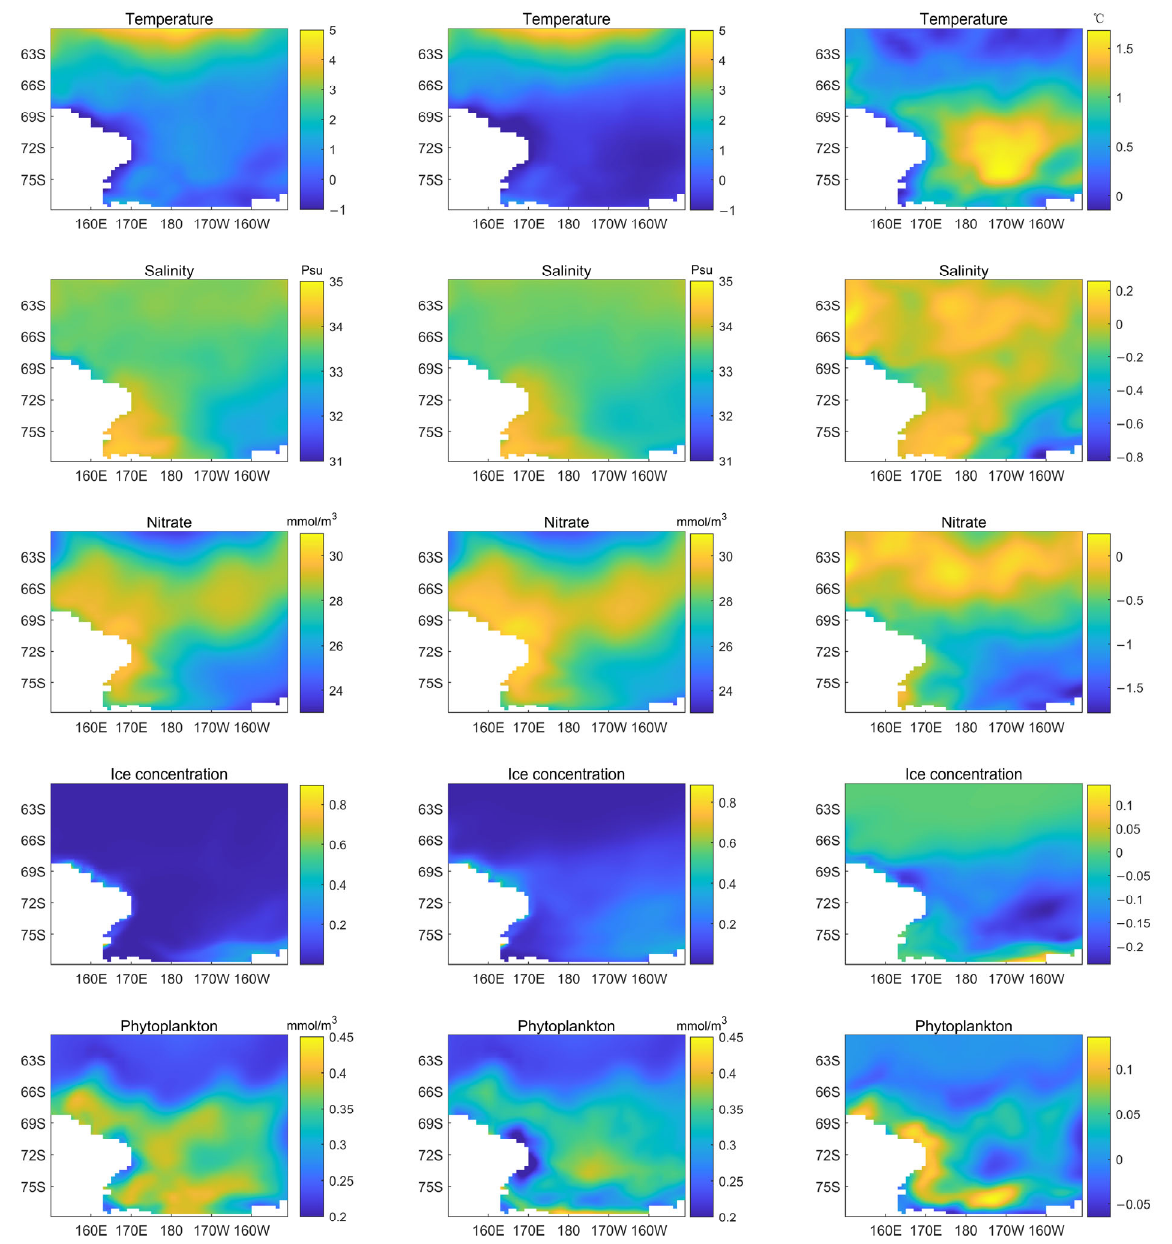
Figure 9. Map distribution of the different environmental variables’ concentration in February: (1) an average of the five warmest years ( left ), (2) an average of all the years ( middle ), and (3) the difference between them ( right ). Note: the concentration range of the color bars is different.